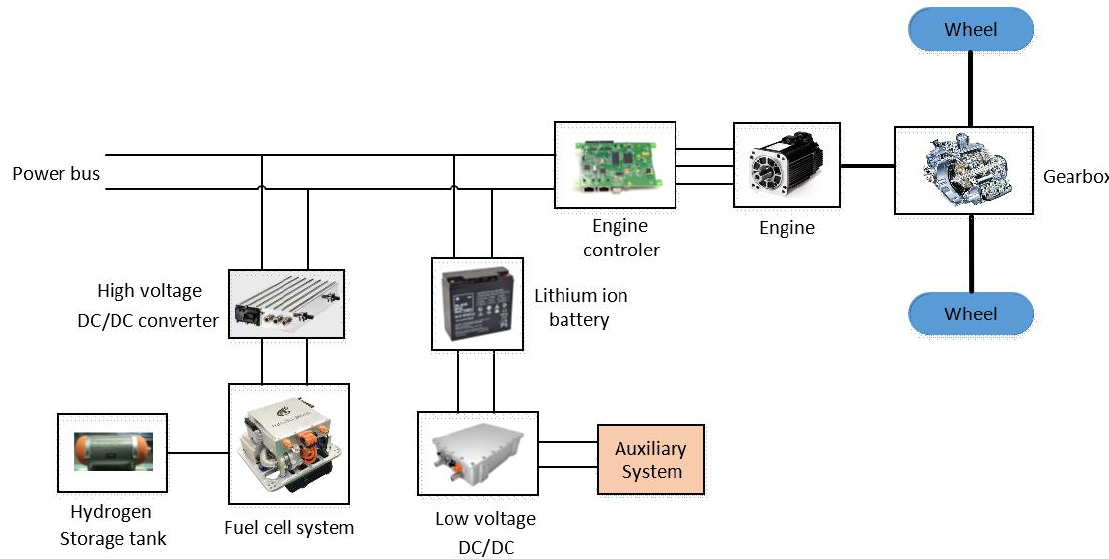
Figure 1. Topological diagram of vehicle powertrain system.